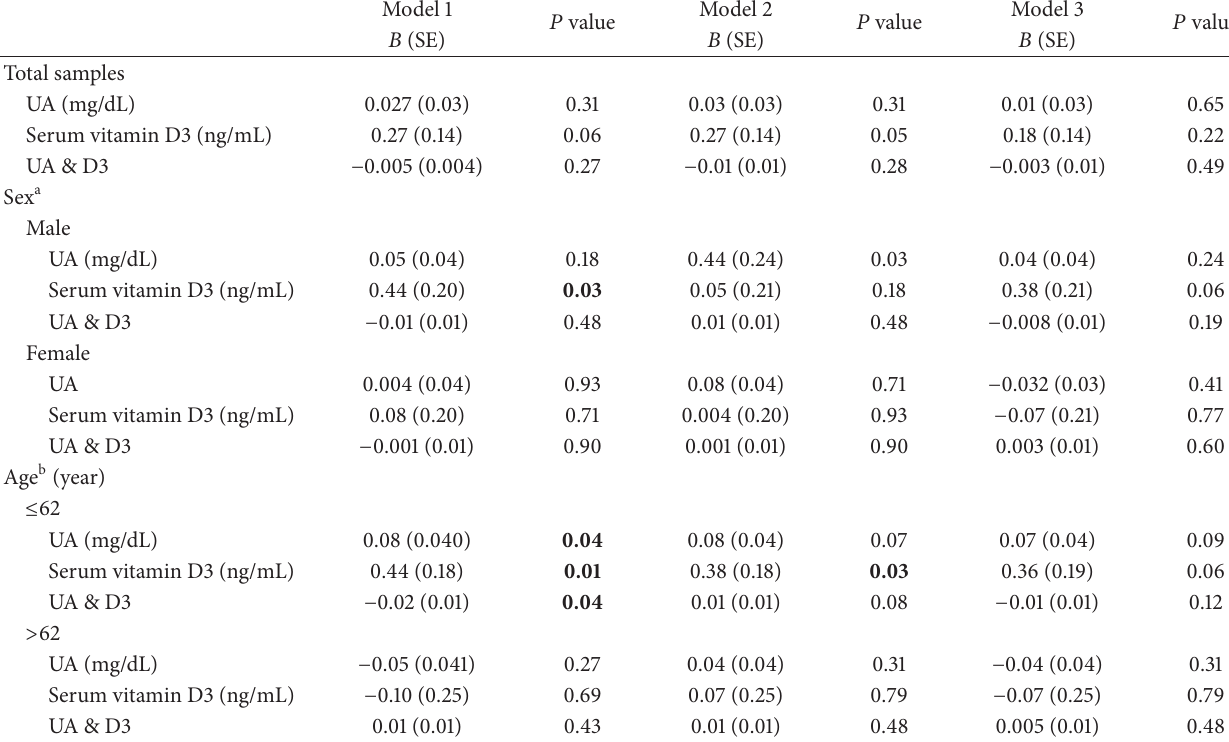
Table 4: The association of UPDRS scores with UA, serum vitamin D3, and their interaction in total sample as well as in age and sex groups 1